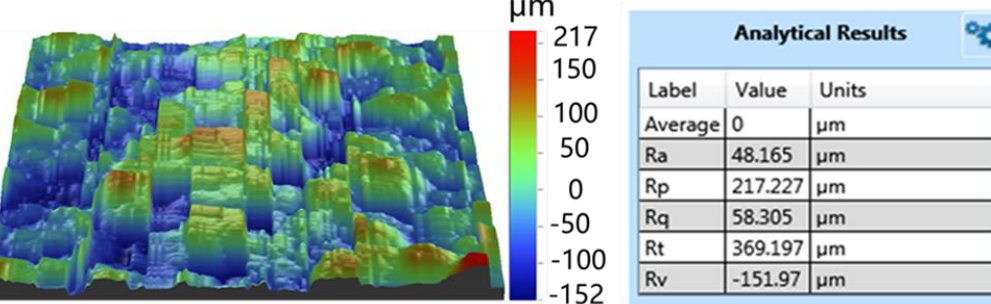
Figure 5. Roughness of the Ti coating.